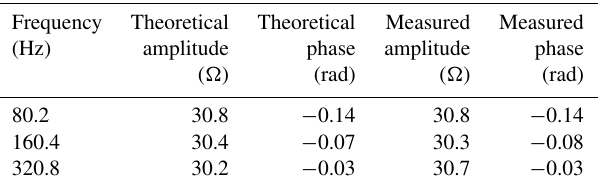
Table 1. Amplitude and phase values of complex resistivity ob- tained with Fig.